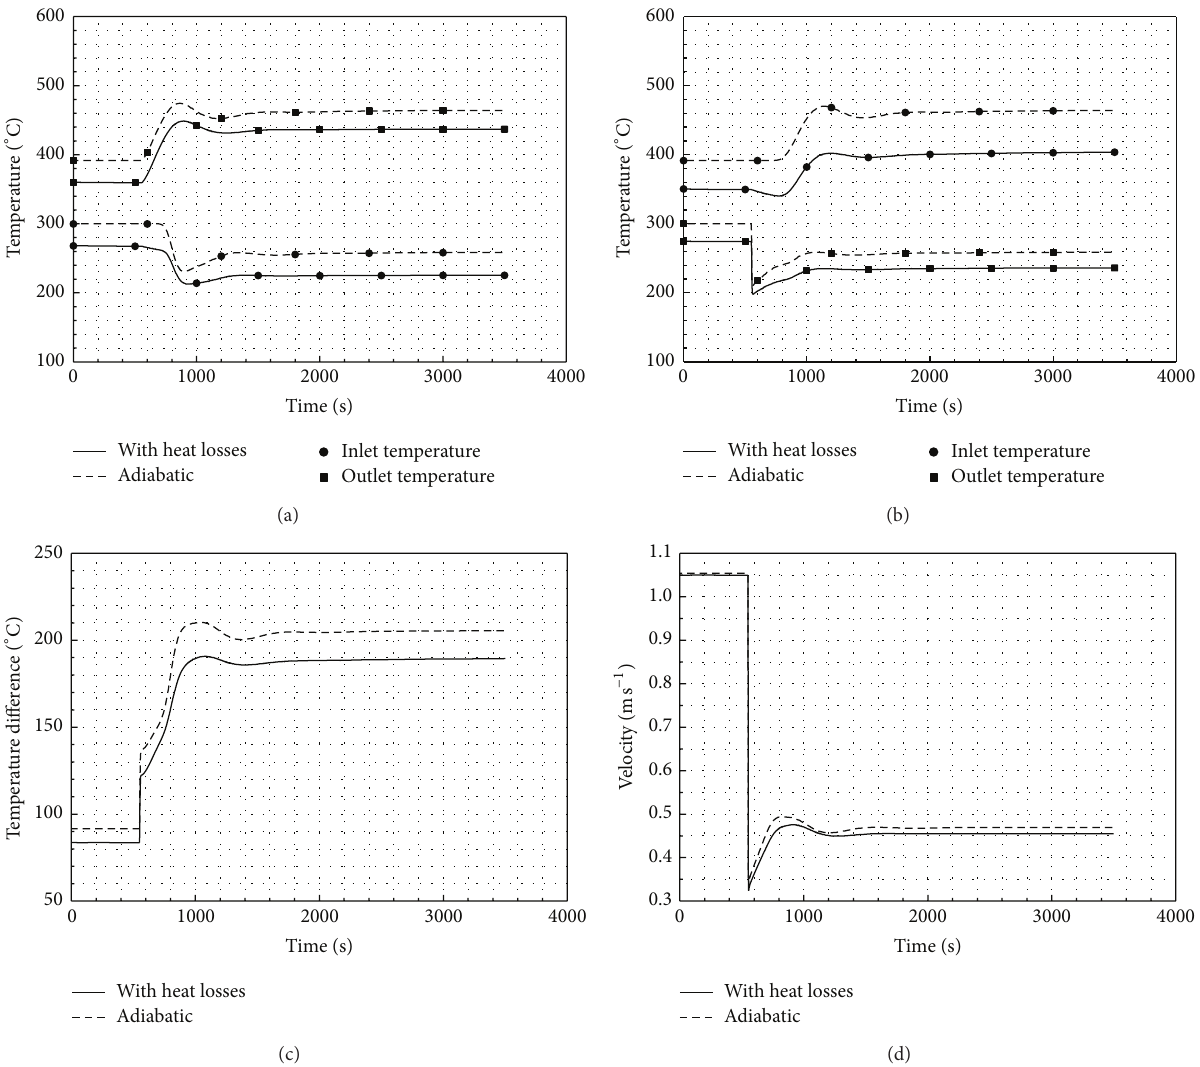
Figure 9: Influence of the heat loss on the performance of NCL. (a) Inlet and outlet temperature of core tank; (b) inlet and outlet temperature of IHX; (c) temperature difference between average temperatures of hot leg and cold leg; (d) coolant velocity in